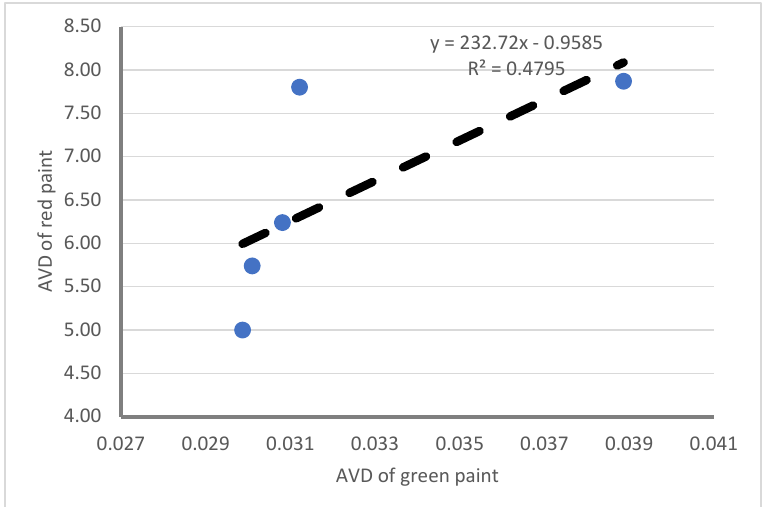
Figure 8. Correlation between AVD values of green and red paint using red laser.